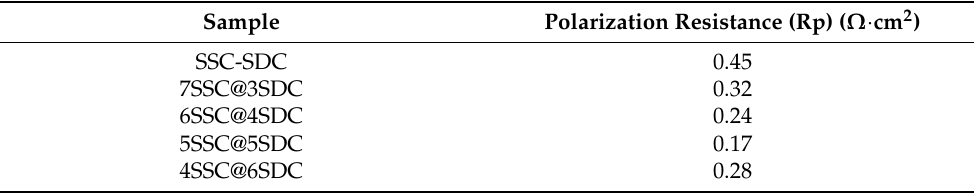
Table 2. The polarization resistance (Rp) values of symmetric cells with composite oxygen